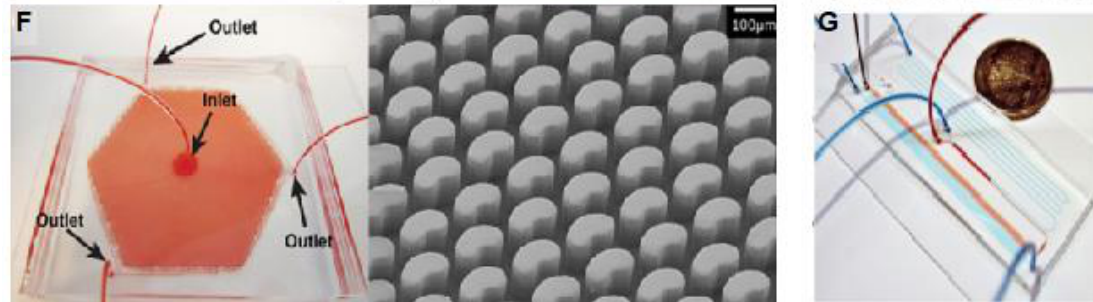
Figure 1. ( A ) The HB-Chip is composed by a collection of microfluidic channels with a single fluid entrance to multiple channels to move again to a single channel to exit, which allows uniform blood flow inside the device [35]. Copyright 2010 National Academy of Sciences. ( B ) Herringbone chip with microstructures in a double-sided channel. The chip was validated with real blood samples from lung cancer detection. CTCs were capture and stained inside the chip with antibodies against CK in red, DAPI in blue, and CD45 in green [36]. “Republished with permission of [Royal Society of Chemistry]; permission conveyed through Copyright Clearance Center, Inc. ( C ) Microfluidic platform for highly efficient retention of CTCs based on a physical variation on cell deformation and diameter. The chip is composed by micro-ellipse filters which were able to detect CTCs from the detection of colon, breast and non-small-cell lung (NSCLC) cancer [38]; Copyright © 2017, Springer Nature. ( D ) Tumor cells captured by a microfluidic platform for high capture efficiency of CTCs (Green), where the CTCs pass through the ellipse filters (Scale bar = 50 µm) [38]; Copyright © 2017, Springer Nature. ( E ) Nanopillar arrays with a diameter of 650 nm with cell membrane details of the capture cells into the device [39]; Copyright © 2017, Springer Nature. ( F ) OncoBean Chip with micropost structures inside the device. The device allows the cell separation by affinity at high flow rates, applying a radial flow, which produces a variation of the shear profile across the device. Licensed under CC BY-NC International License. The final, published version of this article is available at [41]. ( G ) Microfluidic device based on the separation of CTCs clusters by Size and Asymmetry. The device was tested with whole blood (red) and colored PBS buffer (blue) [42]; Copyright © 2017, Springer Nature.